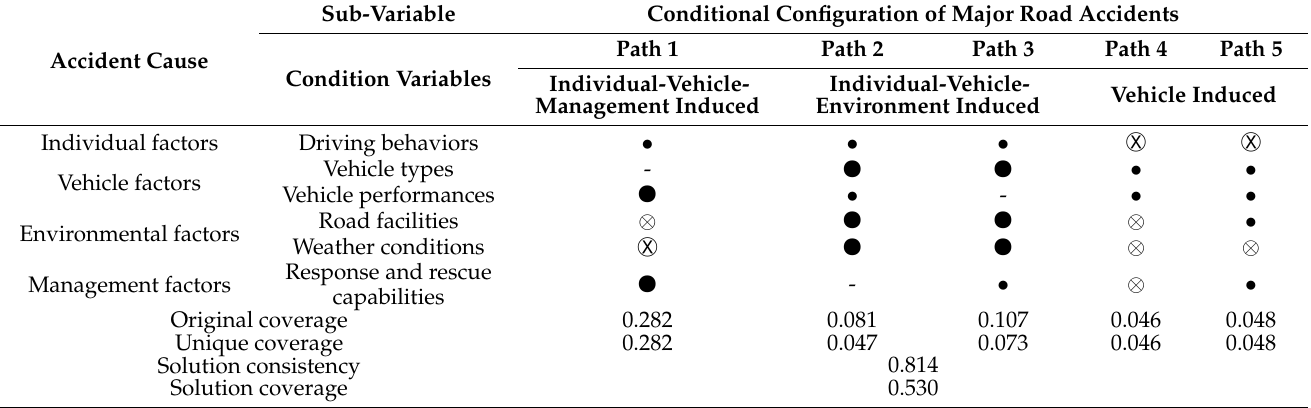
Table 3. The realization of the configuration of major road accidents by using fsQCA.